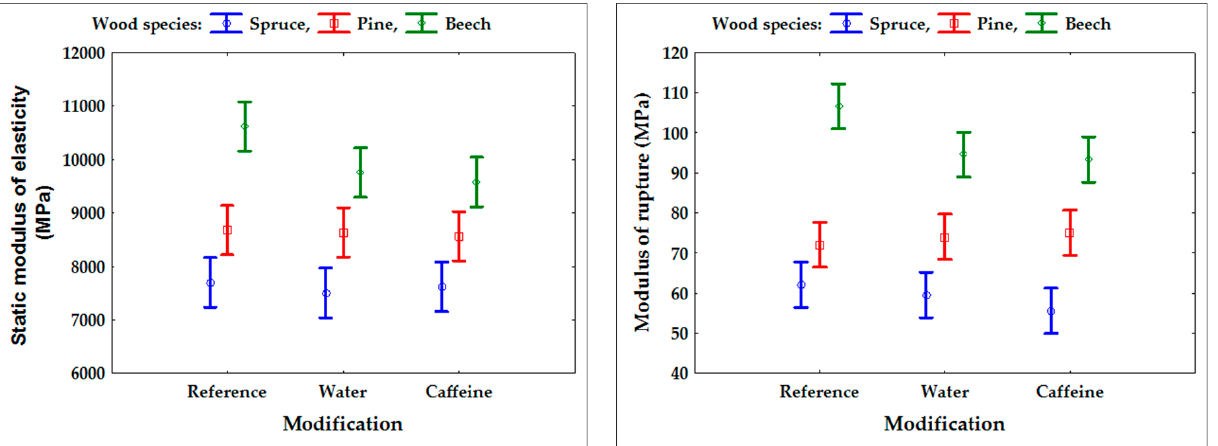
Figure 3. Degradation by wood-destroying fungi.